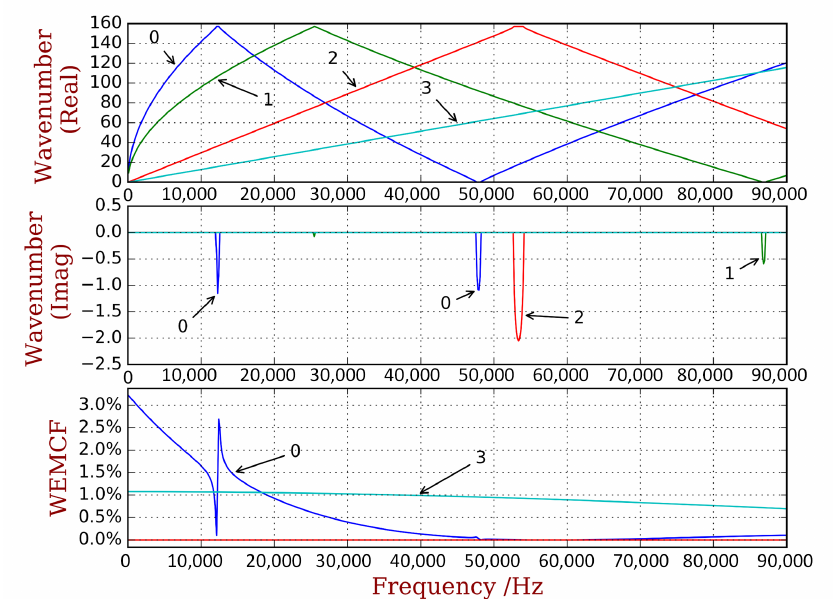
Figure 9. Dispersion curves and WEMCF for the piezoelectric waveguide with unit cell C.